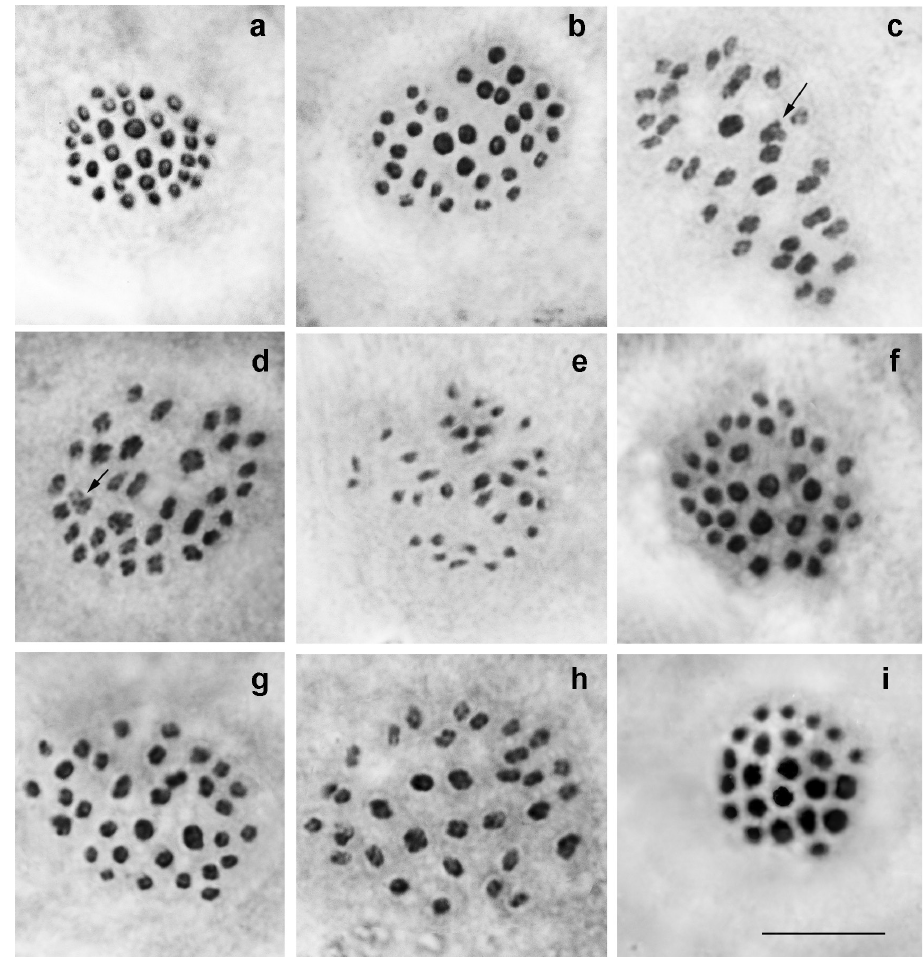
Figure 2. Karyotypes of P. ninae , P. aserbeidschanus and P. australorossicus sp. n. Trivalents are indicated by arrows. a P. ninae , sample 2014VL34, MI, n=34 b P. ninae , sample 2014VL39, MI, n=33 c P. ninae , sample 2014VL33, MI, n=32 bivalents + 1 trivalent (heterozygote for fusion/fission) d P. ninae , sample 2014VL60, n=32 bivalents + 1 trivalent (heterozygote for fusion/fission) e P. ninae , sample 2014VL33, MII, n=33 f P. aserbeidschanus , sample 05A406, MI, n=32 g P. aserbeidschanus , sample 05A387, MI, n=33 h P. aserbeidschanus , sample 05A387, MI, n=33 i P. australorossicus sp. n., sample DK-27-97-1, MI, n=23. Bar = 10